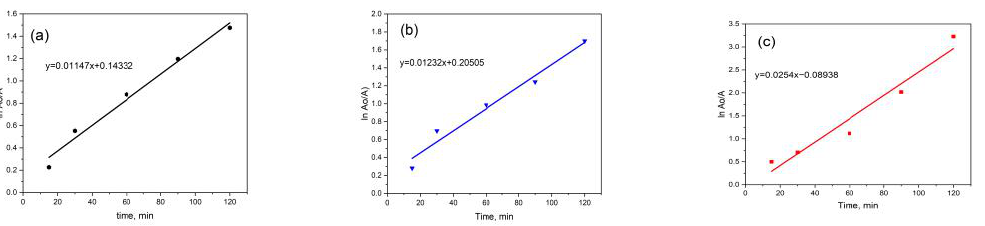
Figure 7. Pseudo-first order kinetics of MB degradation over different catalyst dosages of Ru- ZnO/SBA-15: ( a ) 10 mg; ( b ) 30 mg; and ( c ) 50 mg.